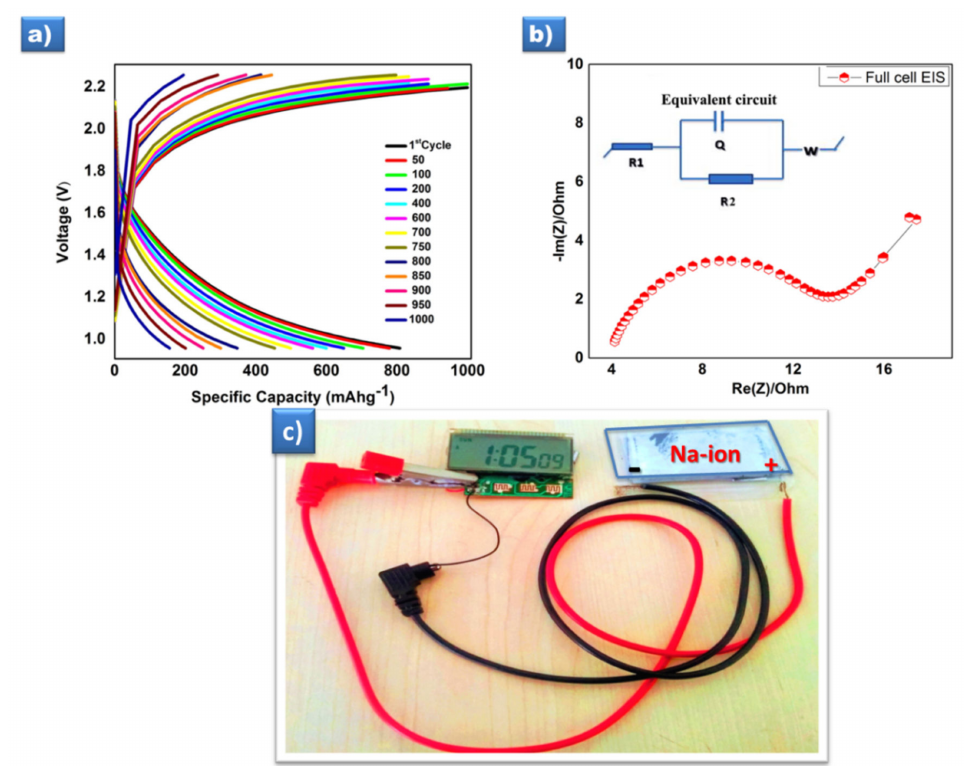
Figure 4. ( a ) Charge discharge curve of a prototype full-cell cycled between 1.0-2.2V at 0.1 C, ( b ) Electrochemical impedance Spectra of the full-cell setup with an equivalent circuit, and ( c ) the prototype of Na-ion full-cell powering the digital